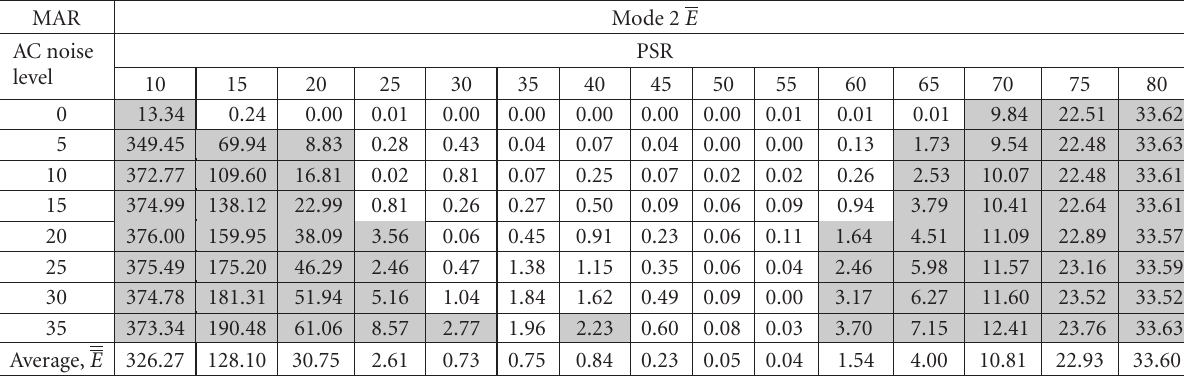
Table 4: MAR E results for mode 2 at for di ff erent noise level and